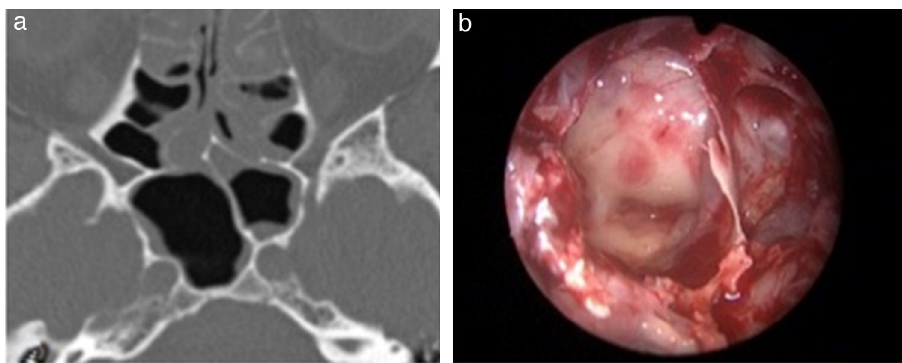
Figure 1 (a) CT scan axial view of an intersphenoid septation in the left internal carotid artery protuberance (ICAp) and (b) intraoperative view (0 ◦ endoscope) showing the same septation in the left ICAp. current article describes the frequency of intrasphenoid sep- tations in the ICAp among a sample of 421 patients analysed using computed tomography (CT) scans and compares these findings with those of previous studies.